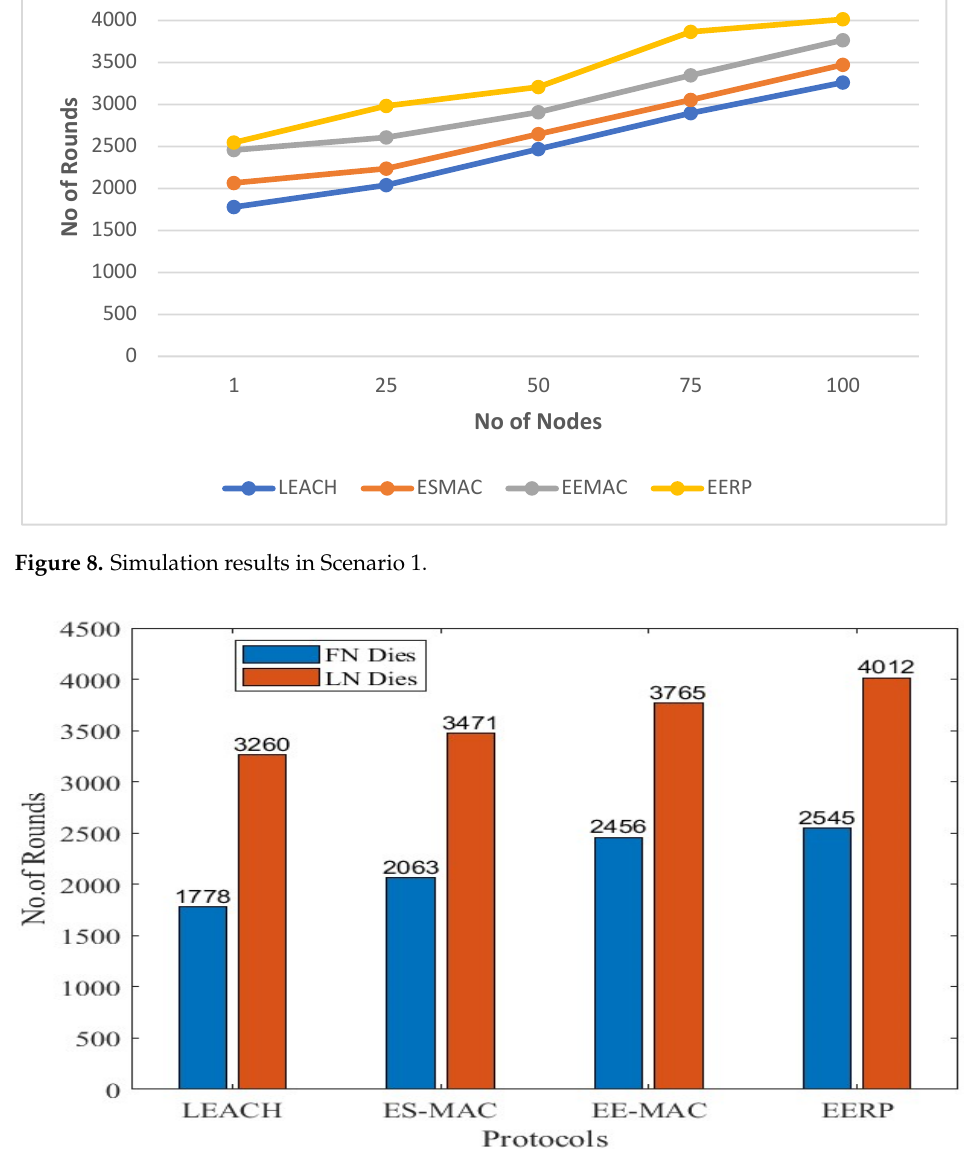
Figure 9. FN and LN deaths in Scenario 1